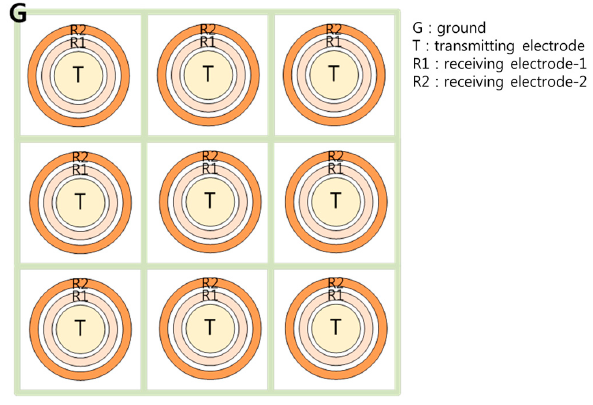
Figure 4. Disposition of multiple probes.